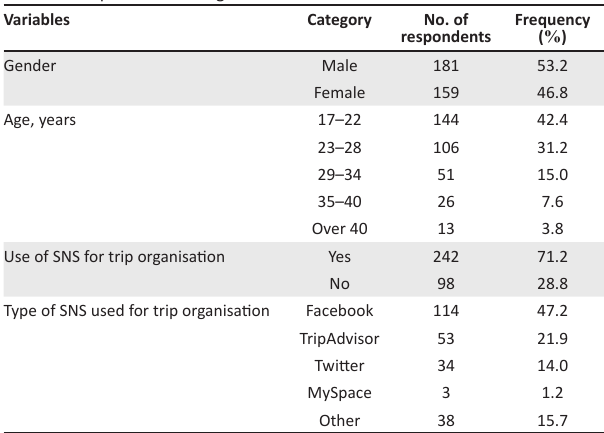
FIGURE 1: Proposed research model.